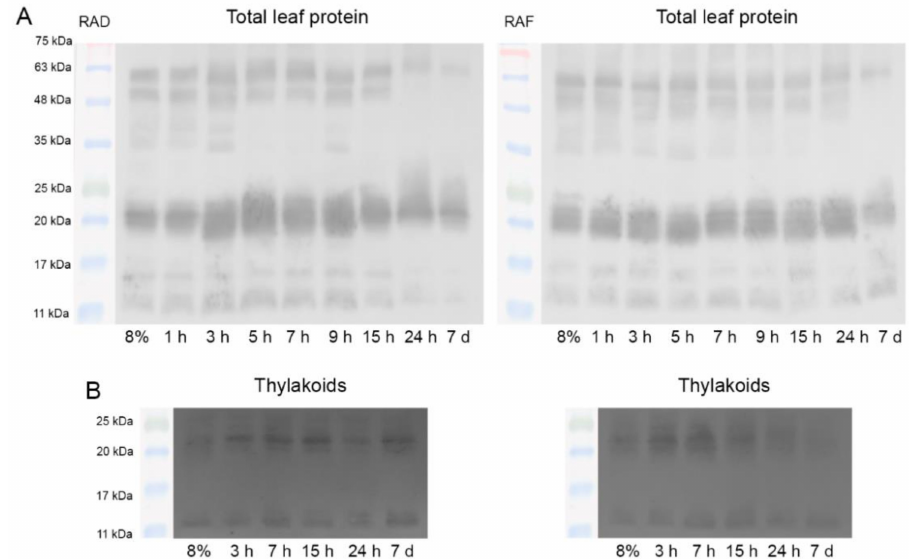
Figure 9. Changes in the relative amount of LEA2 group stress-induced proteins, detected by Western blot analysis against conserved K-segments of dehydrins in total leaf proteins ( A ) and in thylakoids ( B ) isolated from H. rhodopensis plants during the recovery from drought- (RAD) and freezing-induced desiccation (RAF).